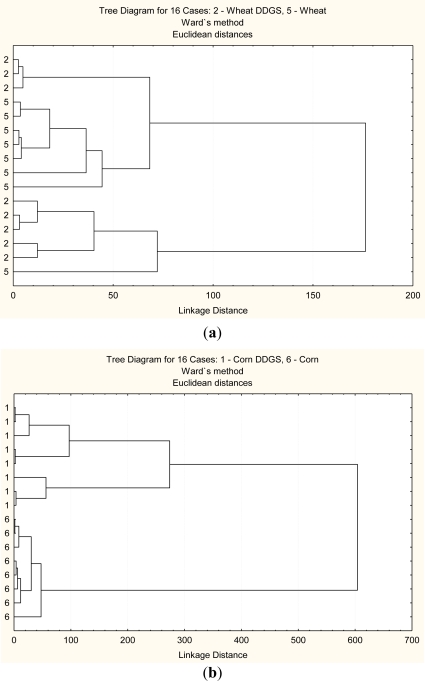
Multivariate molecular spectral analyses of the co-products from bioethanol production at the fingerprint region (ca. 1800–827 cm−1): CLA cluster analyses of molecular spectrum (Region ca. 1800–827 cm−1; Distance method: Euclidean; Cluster method: Ward’s algorithm); Principal component analysis (PCA) analyses of molecular mid-IR spectrum. (a,c) wheat DDGS (code 2) vs. wheat (code 5); (b,d) corn DDGS (code 1) vs. corn (code 6). (a) Cluster analysis: molecular structure of wheat vs. molecular structure of wheat DDGS; (b) Cluster analysis: molecular structure of corn vs. molecular structure of corn DDGS; (c) PCA: molecular structure of wheat vs. molecular structure of wheat DDGS. 1st vs. 2nd principal component; (d) PCA: molecular structure of corn vs. molecular structure of corn DDGS. 1st vs. 2nd principal component.